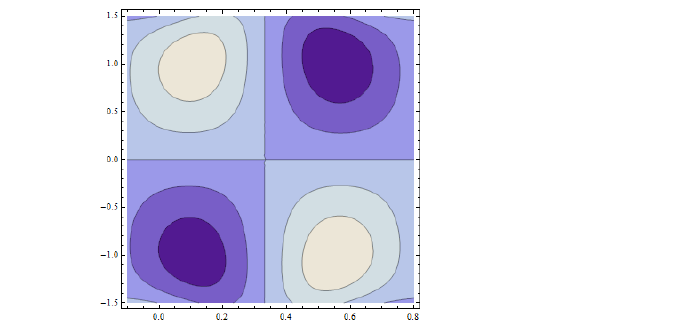
Figure 25. Pattern of streamlines when (cid:101) = 0.1, t = 0.1, m = 0.04, m 1 = 2, E 1 = 0.2, E 2 = 0.2, E 3 = 0.3, We = 0 and n =